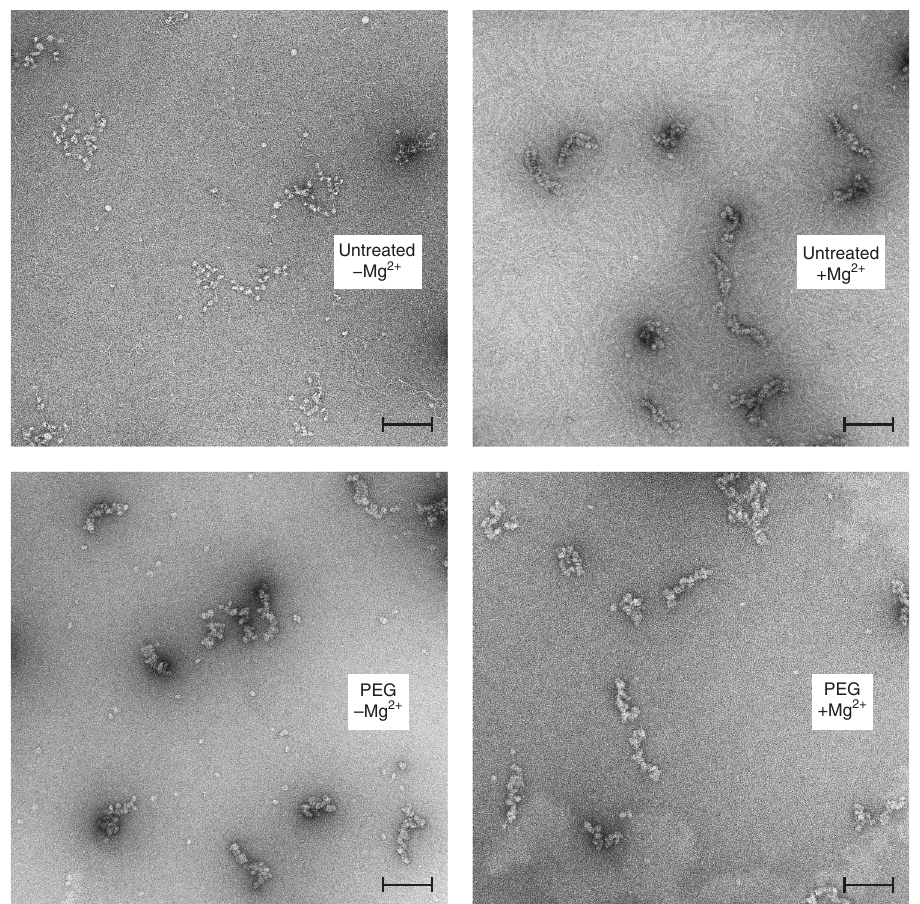
Fig. 7 Electron microscopy of negatively stained native and binuclear-treated nucleosome array. Samples include native array (untreated) with and without 1.6 mM Mg 2+ and PEG-treated array with and without 0.5 mM Mg 2+ (binuclear-treated array aggregates/precipitates at higher Mg 2+ concentrations). The black scale bar inset corresponds to 100